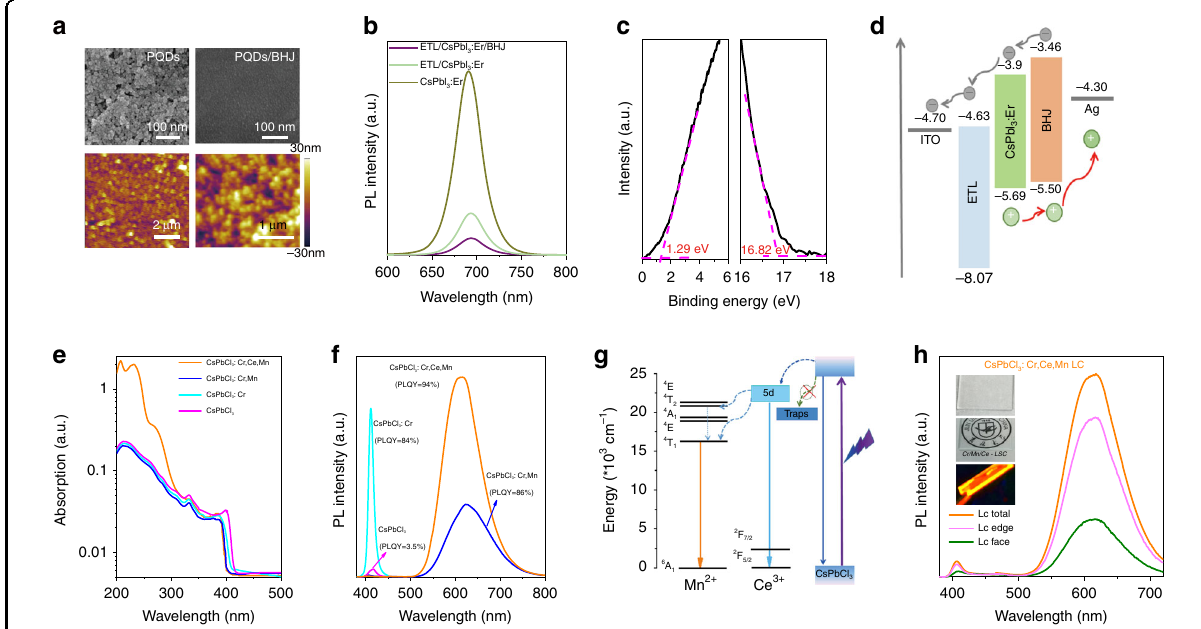
Fig. 4 Photoelectric characteristics of BHJ and Cr/Ce/Mn-LC. a SEM (top) and AFM (bottom) images of the CsPbI 3 :Er 3 + (7.7%) PQDs fi lm and the CsPbI 3 :Er 3 + (7.7%) PQDs /BHJ fi lm. b Emission spectra of CsPbI 3 :Er 3 + (7.7%) PQDs fi lm, ETL/CsPbI 3 :Er 3 + (7.7%) PQDs fi lm, and ETL/CsPbI 3 :Er 3 + (7.7%) PQDs/BHJ fi lm. c UPS curves of CsPbI 3 :Er 3 + (7.7%) PQDs fi lm. d Energy band diagram of each layer in the PDs. e , f Absorption spectra, emission spectra, and PLQY of undoped, Cr 3 + , Cr 3 + /Mn 2 + , and Cr 3 + /Mn 2 + /Ce 3 + doped CsPbCl 3 PQDs. g Energy transfer mechanism of CsPbCl 3 : Cr 3 + , Ce 3 + , Mn 2 + PQDs. h Total, face, and edge emissions measured for a Cr/Ce/Mn-LC using Cr 3 + ,Mn 2 + ,Ce 3 + doped CsPbCl 3 PQDs. The inset is the picture of Cr/Ce/Mn-LC under sunlight and UV